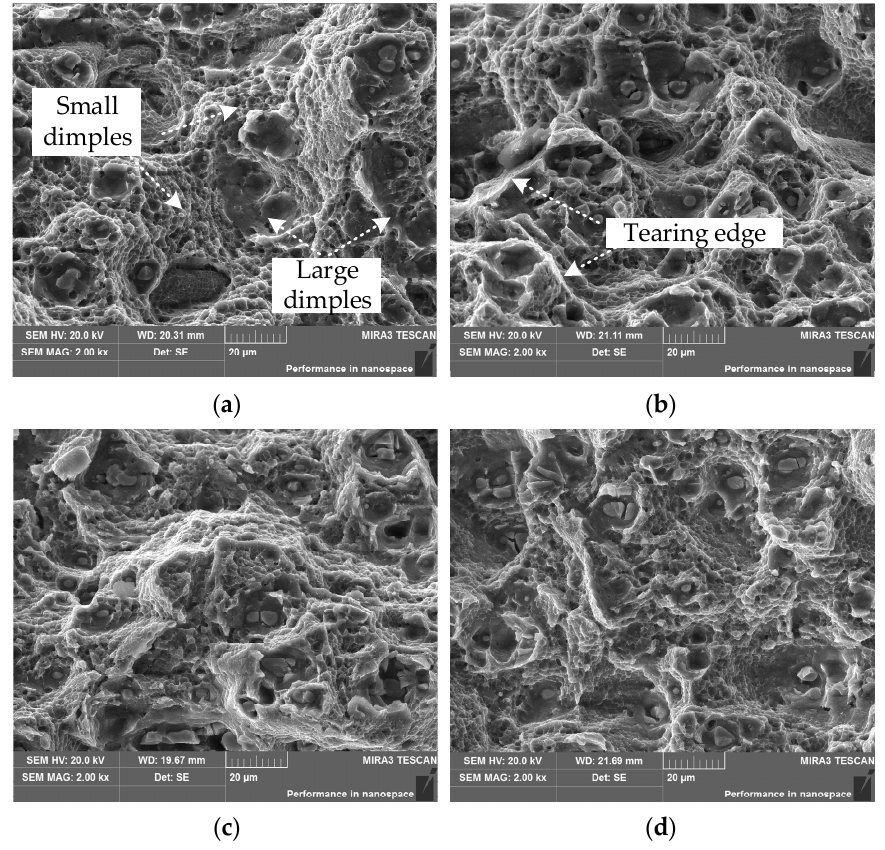
Figure 6. SEM images of fatigue-crack transient region at different creep-aging temperatures: ( a ) 100 ◦ C—9 h; ( b ) 130 ◦ C—9 h; ( c ) 160 ◦ C—9 h; ( d ) 180 ◦ C—9 °C—9 h; ( b ) 130 °C—9 h; ( c ) 160 °C—9 h; ( d ) 180 °C—9 h. ( a ) 100